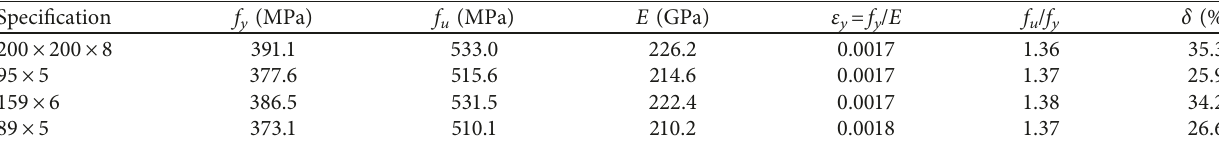
Table 2: Test result of steel tubular material